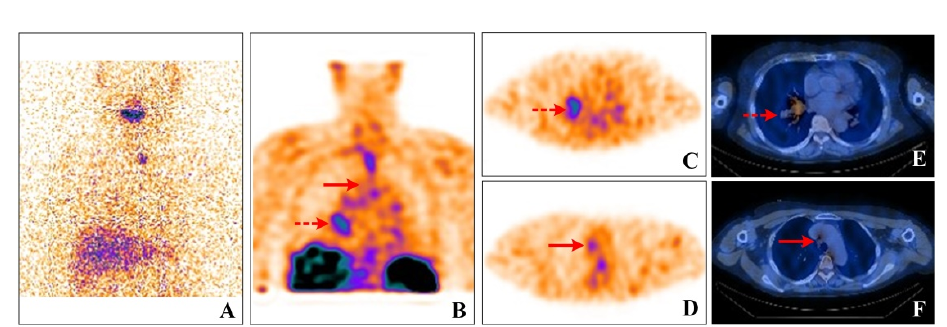
Figure 1. 131 I whole-body scan(WBS) ( A ), 99m Tc-3PRGD2 SPECT/CT WBS ( B ), 99m Tc-3PRGD2 SPECT/CT imaging ( C – F ). A 57-year-old female with papillary thyroid carcinoma (PTC) was sus-